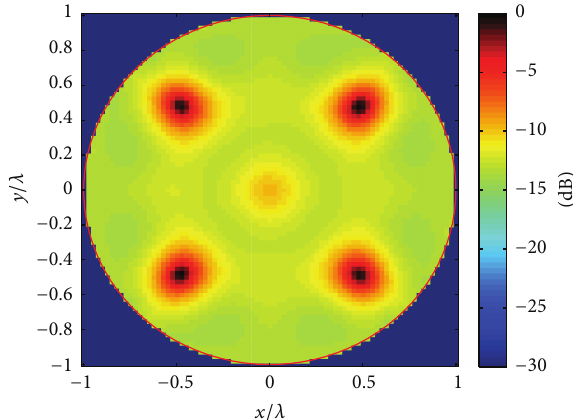
example, metallic rebar embedded in a masonry structure.